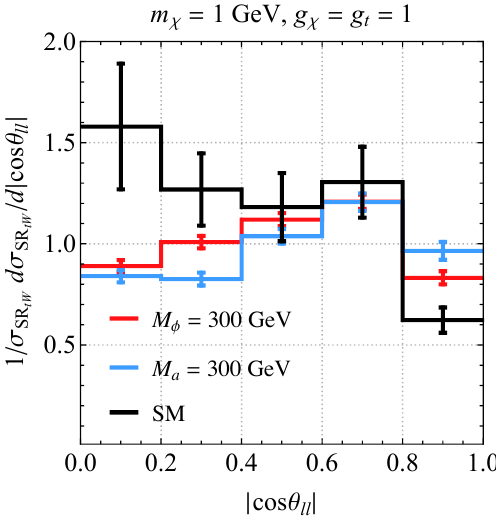
Figure 7 . Normalised j cos (cid:18) ll j distributions of the combined t (cid:22) t + E miss and the SM background at the 14 TeV LHC. The depicted results impose the selections SR tW summarised in table 1. The used parameter choices for the s -channel DM simpli(cid:12)ed models are indicated in the legend and the headline of the panel and the error bars represent the statistical errors associated to our MC